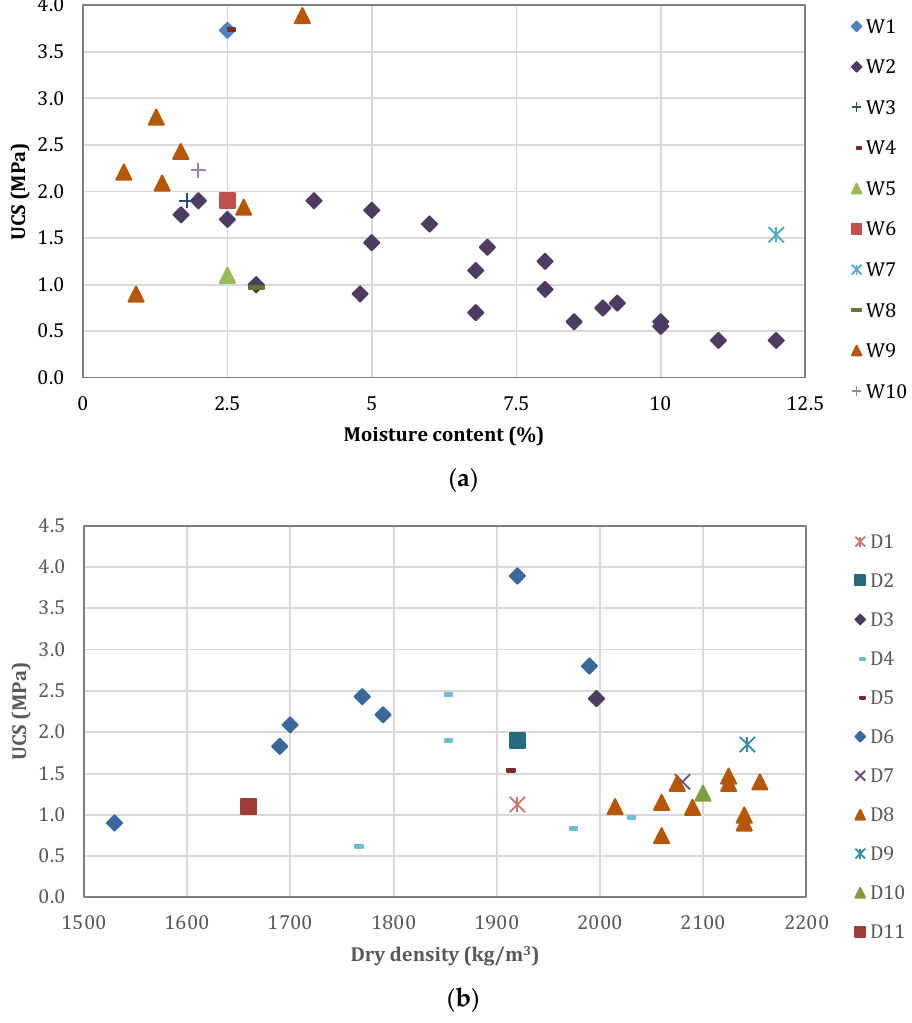
Figure 1. PSD for soils and soil mixtures used in RE structures in: ( a ) Australia: A1—A3 [34], A4 [36]; A5—A7 [37]; ( b ) France: F2 [31], F1 [34], F5—F7 [35], F3 [40], F8—F10 [46], F4 [48]; and ( c ) Portugal: P1—P6 [4], P7—P10 [41], P11 [42], P12 [43].